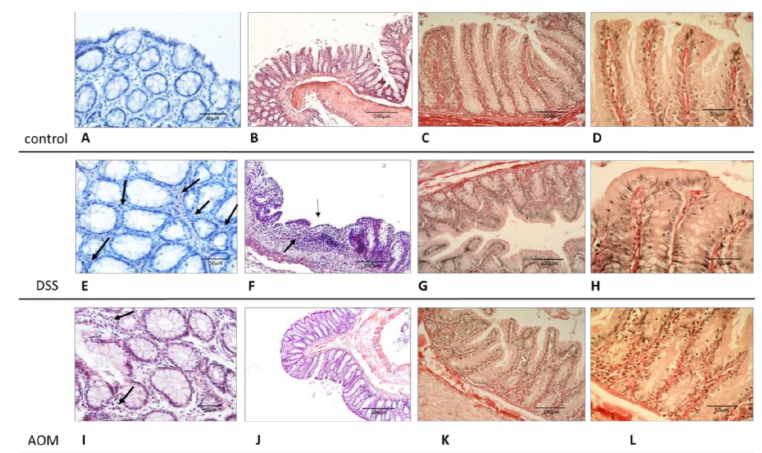
Figure 3. Histology of the colon mucosa from healthy, DSS-, and AOM-treated rats. The histological evaluation showed modification in the regular disposition and homogeneous shape of the crypts asso- ciated with increased cellular inter-cryptal infiltrate after DSS and AOM treatments in comparison to the control ( A , E , I ). The DSS-treated group showed evidence of colitis with parvicellular infiltrate (( E ), arrows, and ( F )); reduction of the crypt length; and, sporadically, little ulcerations ( F ). Mild changes in the crypts shape and cell infiltrate ( I , arrows) resulted in the mucosa after AOM induction ( I – L ). The collagen structures appeared enhanced after each type of treatment (picrosirius stain, red; ( D , H , L )). ( A – D ) healthy rats; ( E – H ) DSS-treated rats; ( I – L ) AOM-treated rats; ( A , B , E , F , I , J ) haematoxylin–eosin staining; ( C , D , G , H , K , L ) picrosirius staining; ( A , E , I ) and ( D , H , L ) 40 × magnification; ( B , F , J ) 10 × magnification; ( C , G , K ) 20 × magnification.